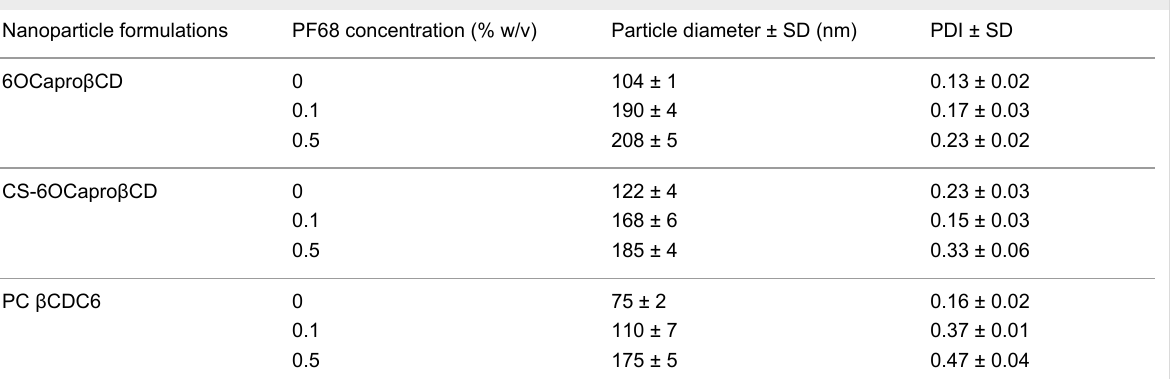
Table 2: Effect of surfactant concentration on nanoparticle diameter and dispersity in ethanol (CD amount is 0.5 mg/mL in all formulations) ( n = 3, ± SD). Nanoparticle formulations